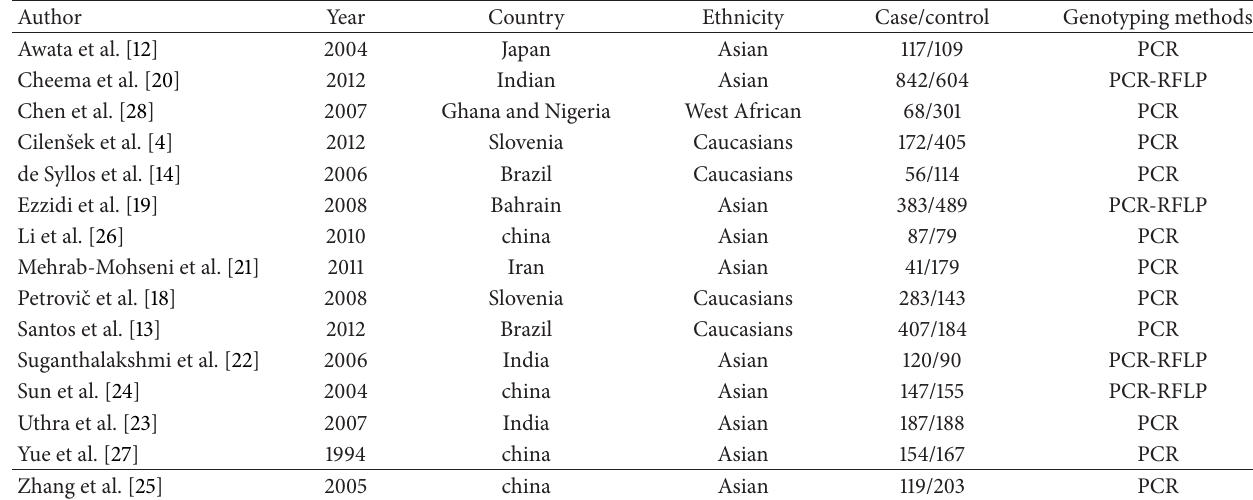
Table 1: Main characteristics of included studies in the meta-analysis.